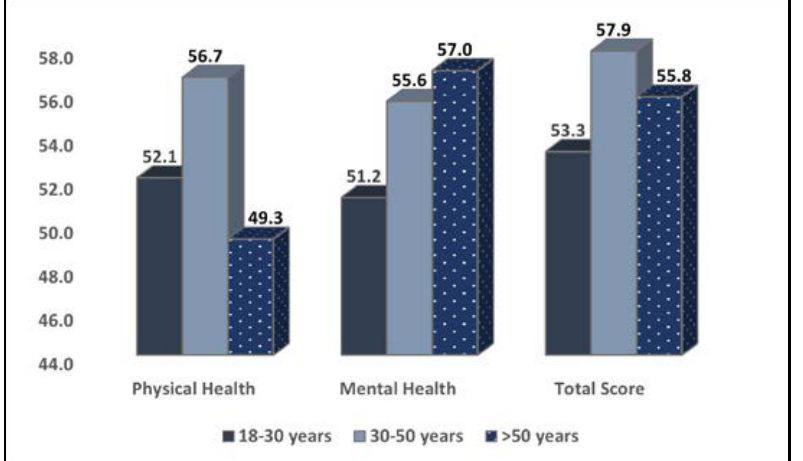
Figure 2. Comparison of quality of life physical and mental scores based on the SF-12 questionnaire stratified by age group.